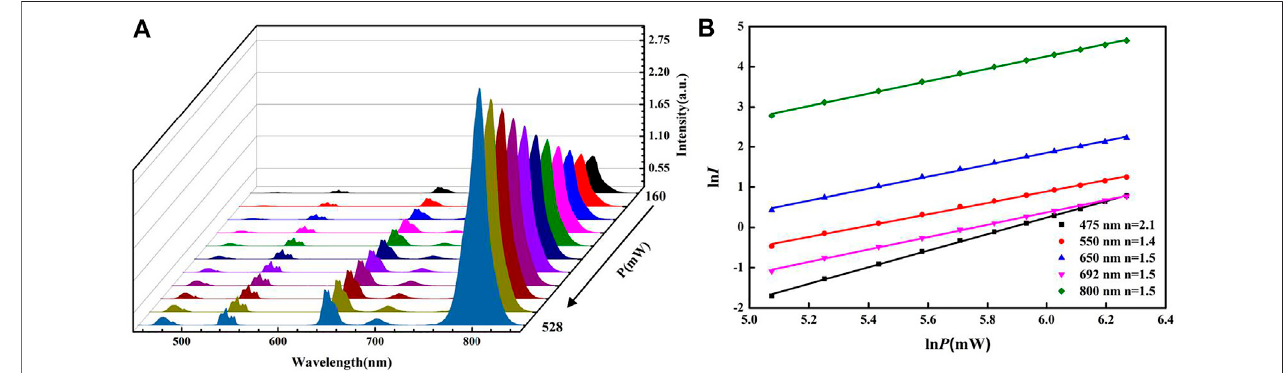
FIGURE 3 | (A) Up-conversion spectra with the increasing power of 980-nm laser; (B) lnI – lnP plot.